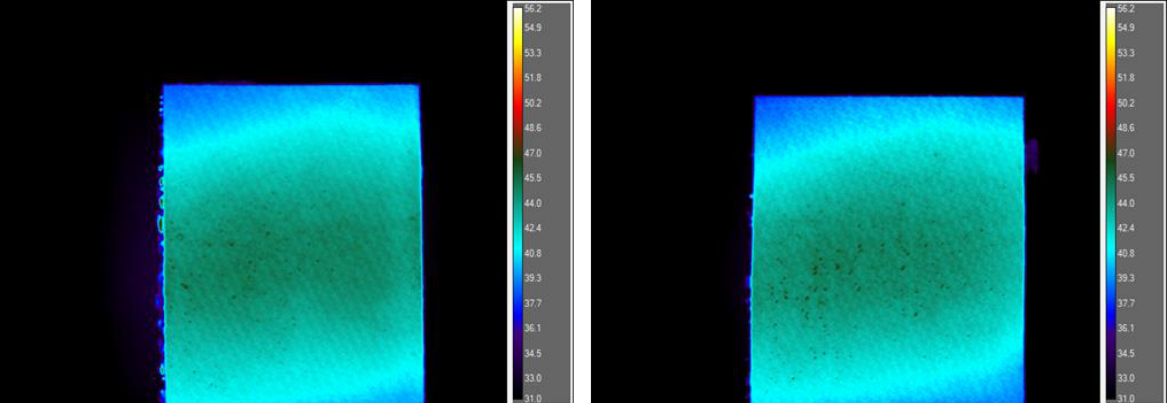
Figure 20. IR thermography pictures of the repaired 3R laminates after impact at 9 J ( left ) and 15 J ( right ).